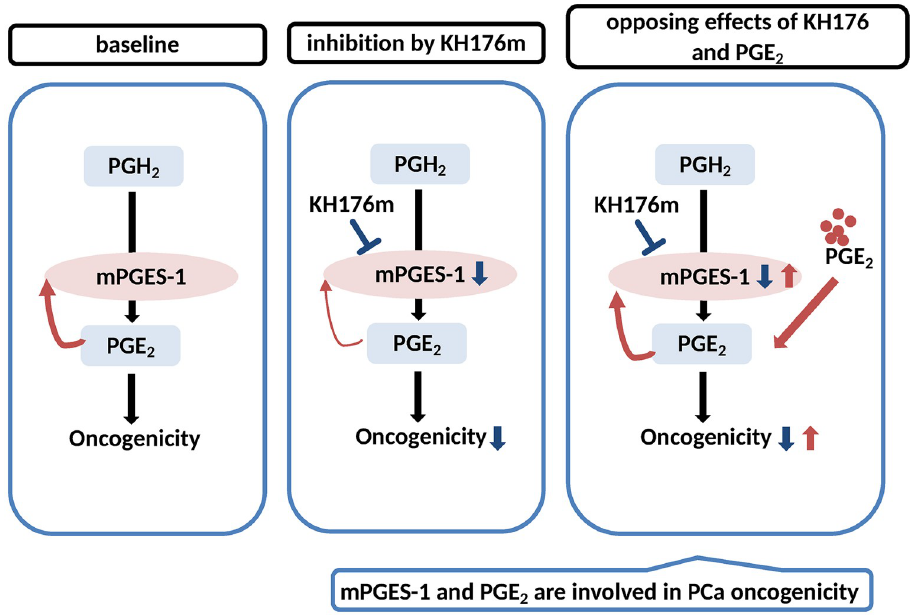
Fig 6. Schematic representation of the results indicating the involvement and interconnection of PGE 2 and mPGES-1 in prostate cancer oncogenicity.